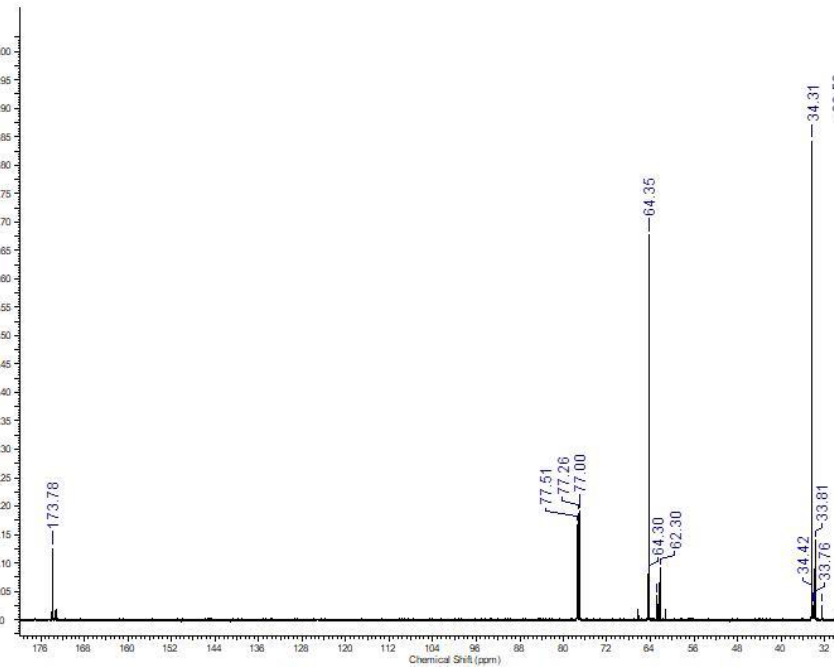
Figure 6. 13 C NMR spectrum of PCL 5000 -PEA 2500 -PCL 5000 sample in CDCl 3.